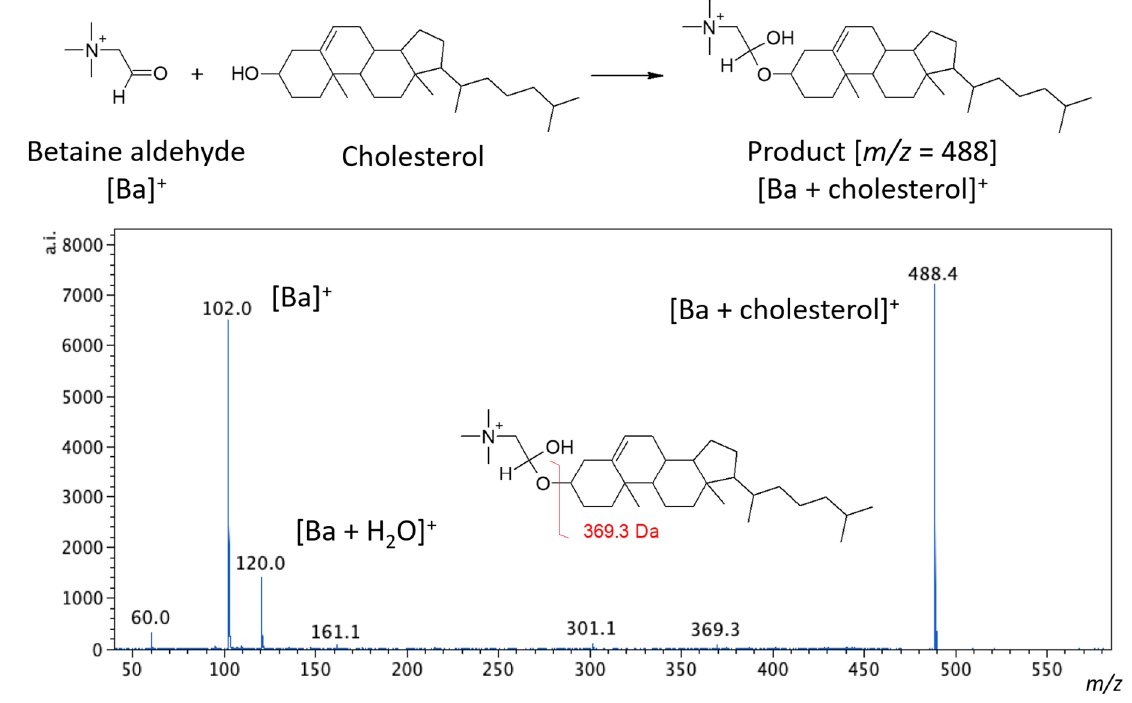
Figure 1. The scheme of cholesterol derivatization reaction with the betaine aldehyde (top) and the MS/MS spectrum for the derivatization product, obtained from the tissue (bottom).